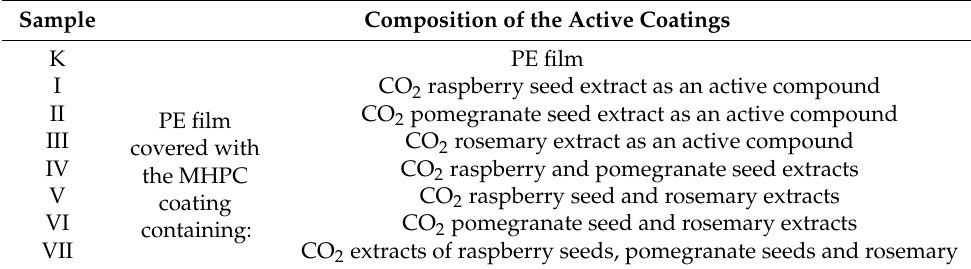
Table 1. Descriptions of the